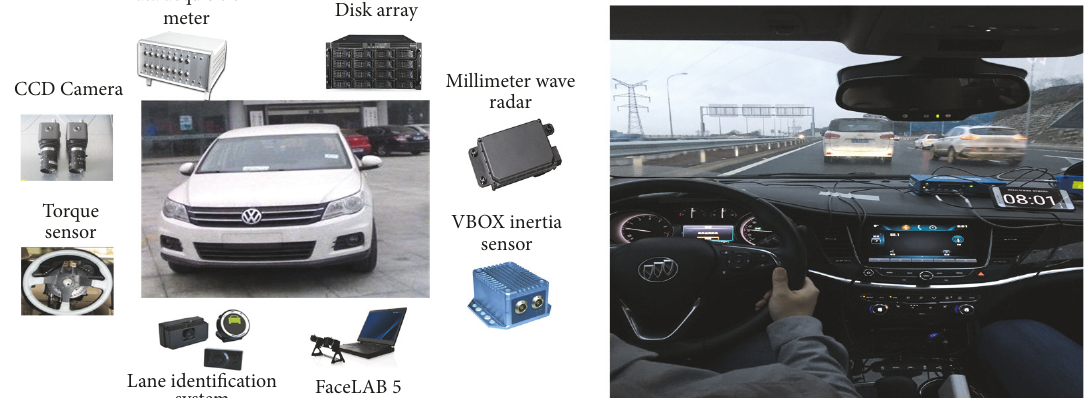
Figure 1: Driving behavior test platform and experimental scenarios.